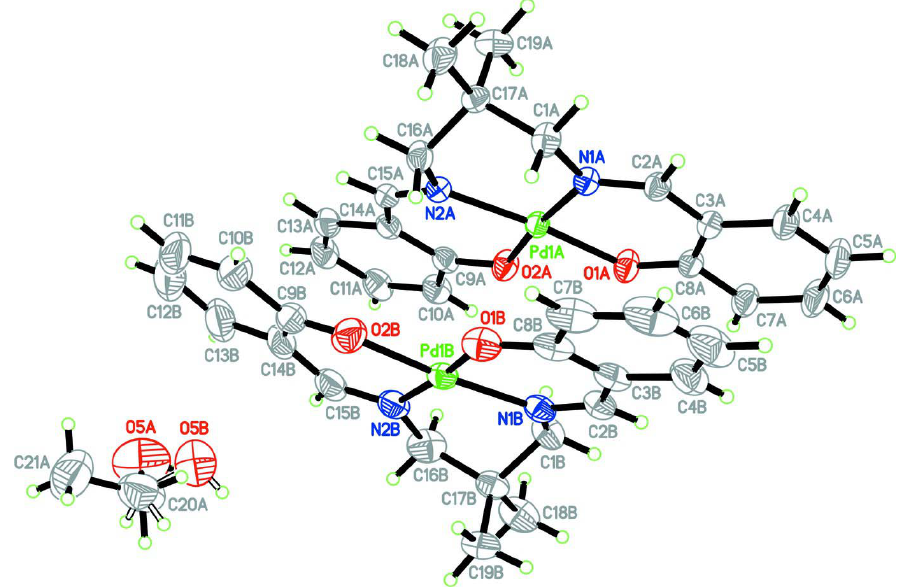
The asymmetric unit of (I), showing 50% probability displacement ellipsoids and the atomic numbering. Disorder of the ethanol molecule is